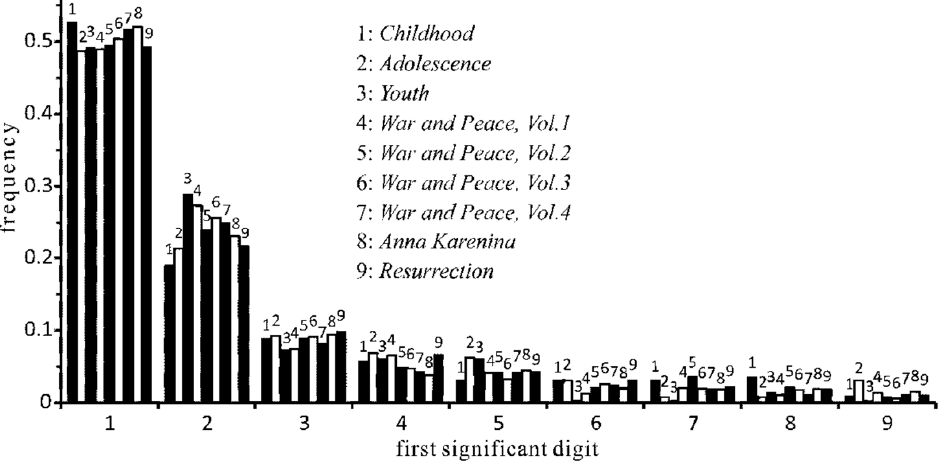
Figure 3. The distribution of the first significant digits of numerals in the works by L. Tolstoy.